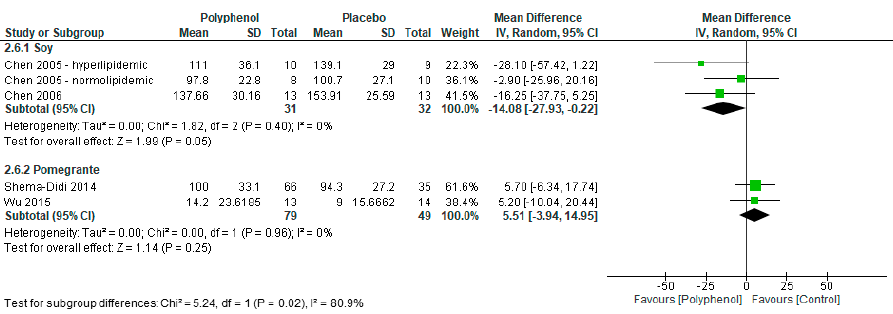
Figure 7. Sensitivity analysis of polyphenol-rich interventions on total cholesterol.